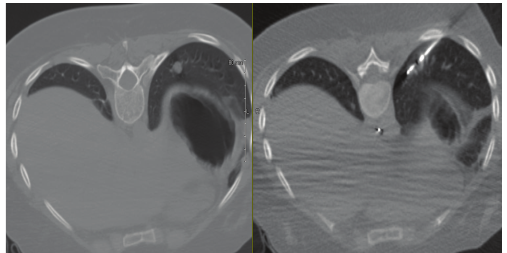
Figure 2: Treatment of a left lung sarcoma metastasis with radiofre- quency